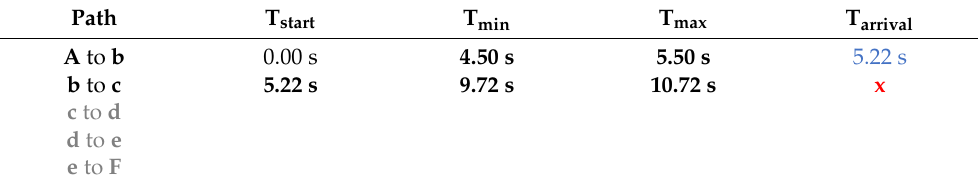
Figure 7. ( a ). Drone movement 2D log on abnormal case: too late. The vertical red line marks the moment when the drone detected an emergency and proceeded with an emergency landing. Due to a collision, the drone far exceeded the expected path, which could possibly have led to secondary collisions. ( b ). Time-window check results. The drone did not make it in the normal arrival time- windows on the path from b to c. The yellow line after the drone left b indicates the moment of the collision. The red line indicates the moment where the event-based controller detected an abnormal situation due to maximum time-window being exceeded. Table 3. The actual numerical time data including T start , T min , T max , and the actual arrival time T arrival for the air collision case. The first interval from A to b was inside the time-window. However, due to the collision after waypoint b, the drone struggled to return to its mission path and exceeded the time-window. This type of emergency is extremely dangerous, yet hard to handle.